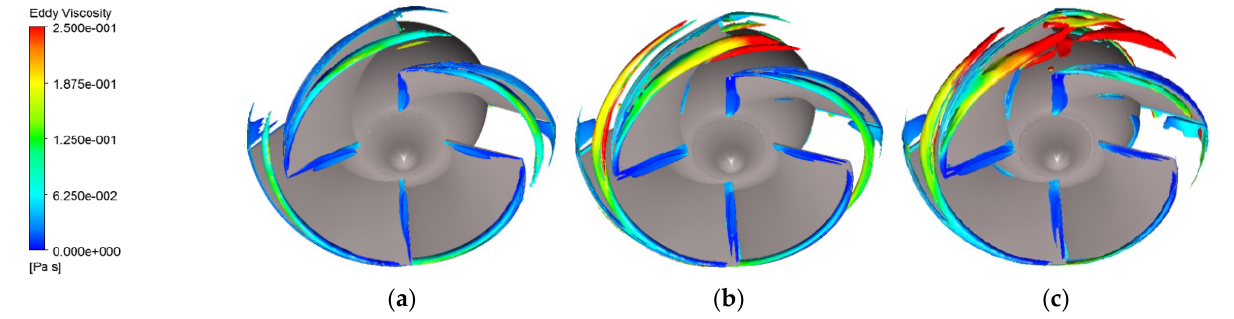
Figure 12. Distribution of vortex core in the flow field of tip clearance, ( a ) e = 0 mm, ( b ) e = 3 × 10 − 1 mm, ( c ) e = 5 × 10 − 1 mm .